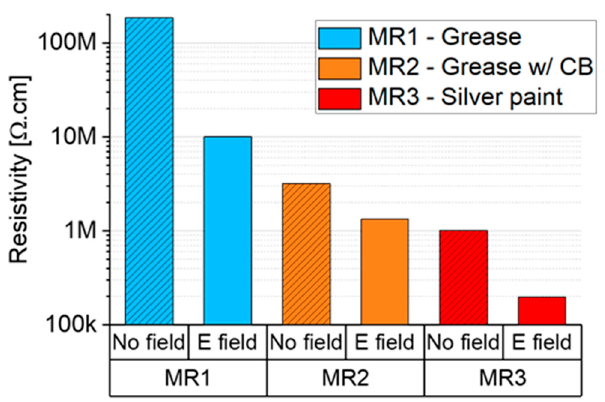
Figure 7. Impact of mold release agent (MR1,2,3) on plate resistivity measured at the electrodes (after cure) for SWCNT / epoxy 0.01 wt.% composites.